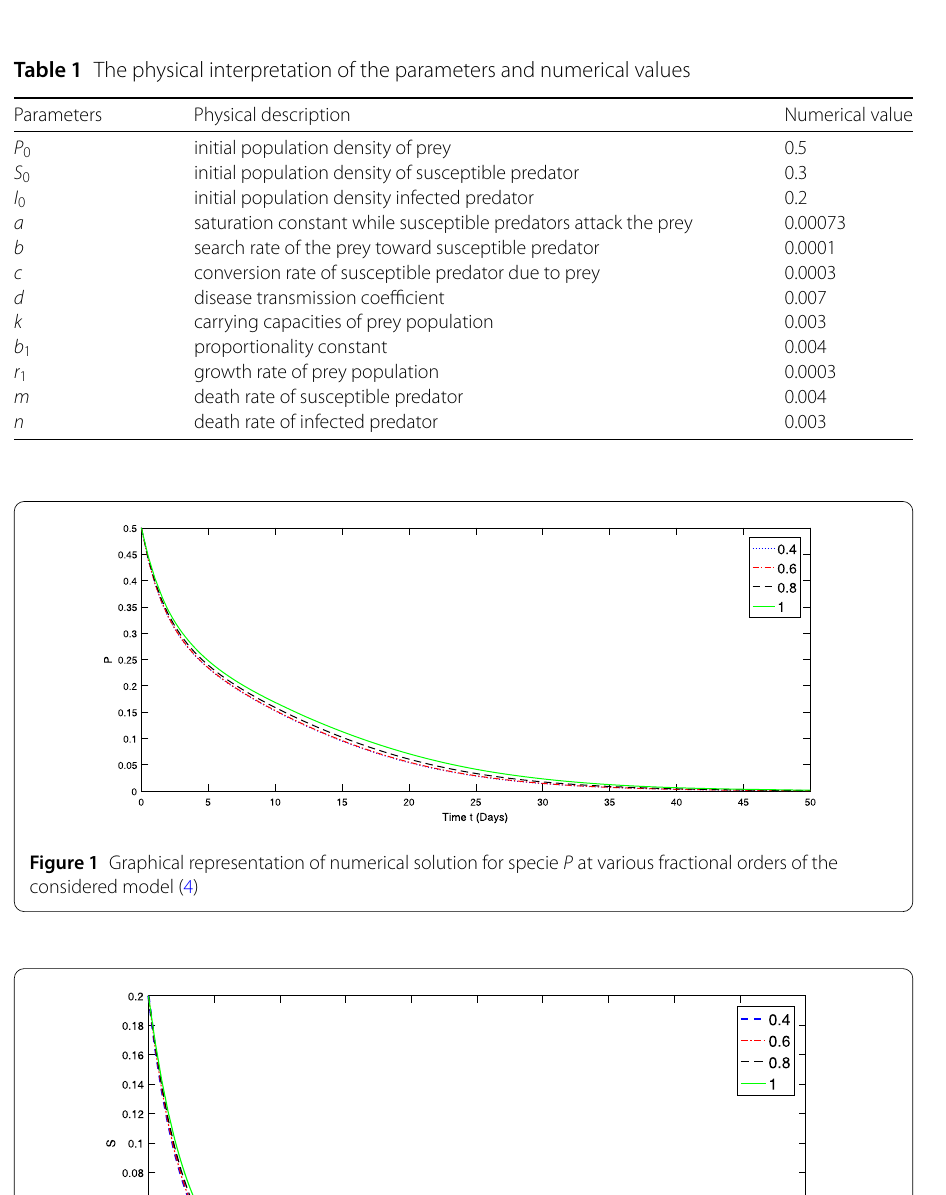
From Figs. 1–3, we observe that species I depends on species P and S . Therefore